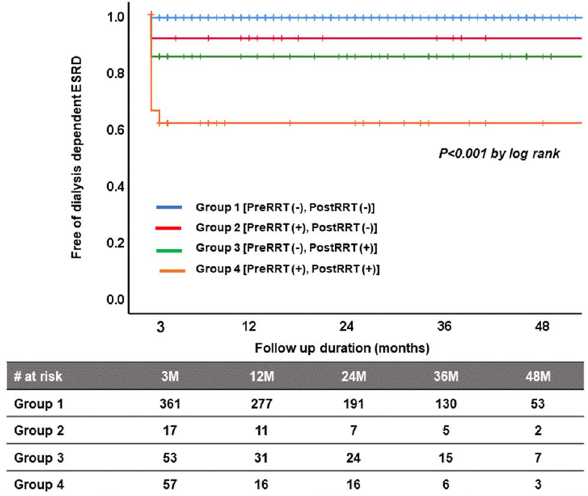
Figure 1. Proportion of patients who developed dialysis-dependent ESRD after HTx in the 4 groups from post- HTx 3 month during follow up. ESRD end-stage renal disease, RRT renal replacement therapy.